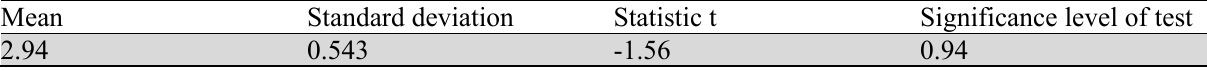
Single sample T test results to investigate achieving economic goals